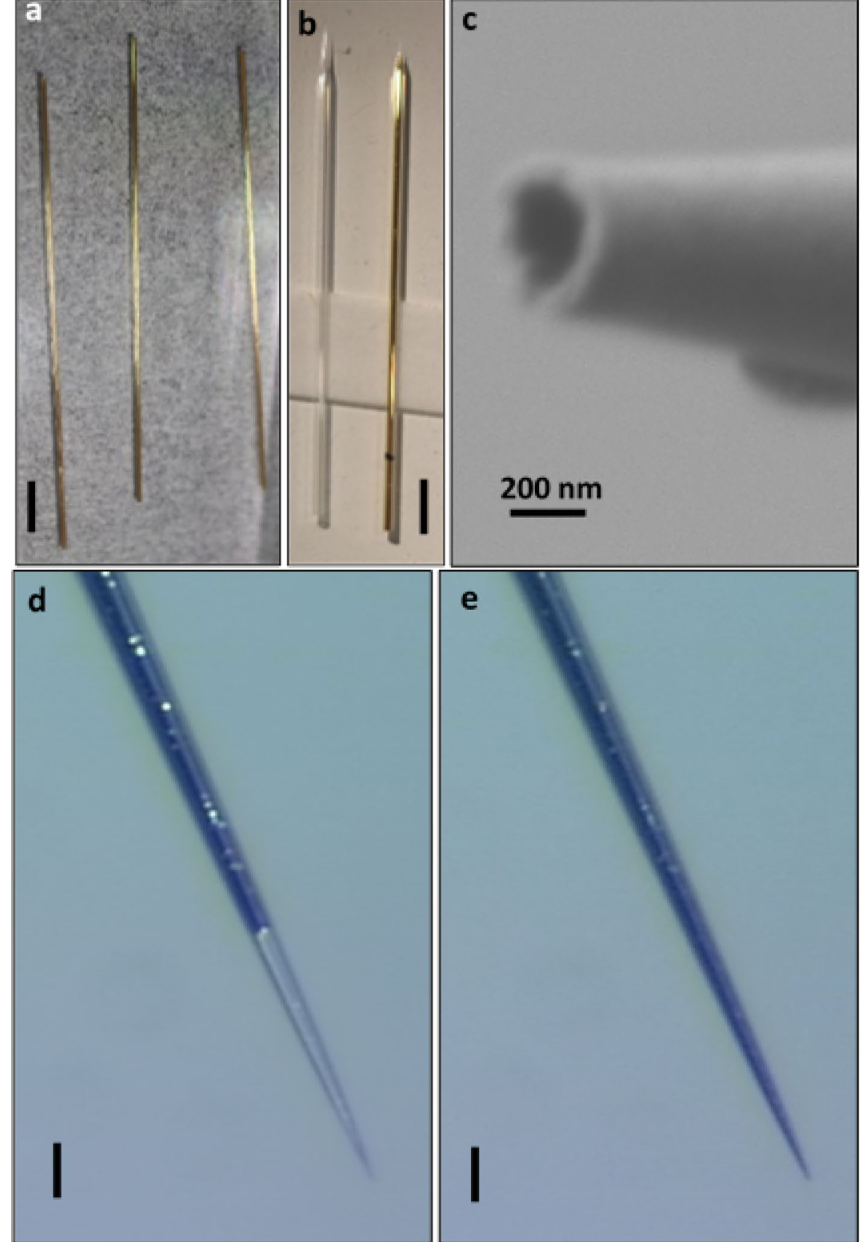
Figure 3. Pipette coating and filling. ( a ) Optical image of three gold-coated glass capillaries. The coating is only from the inside; it is continuous and conductive. Scale bar is 10 mm. ( b ) Optical image of two nanopipettes, bare (left) and coated (right), for comparison. The coating becomes sparser towards the aperture due to the thermal extrusion process. Scale bar is 5 mm. ( c ) SEM micrograph of a tip of a coated pipette as in ( b ), formed under thermal extrusion. ( d , e ) Optical images of a coated nanopipette, at the initial, ( d ), and final, ( e ), stages of filling with EGaIn, respectively. Scale bar is 20 µm. Traces of the coating are barely visible, having been dissolved inside the EGaIn. To completely fill the pipette requires ~ 15–25 atm. Once the pipette is filled, the pressure is dropped, and the pipette remains full. A movie of the filling process is available as Supplementary Information